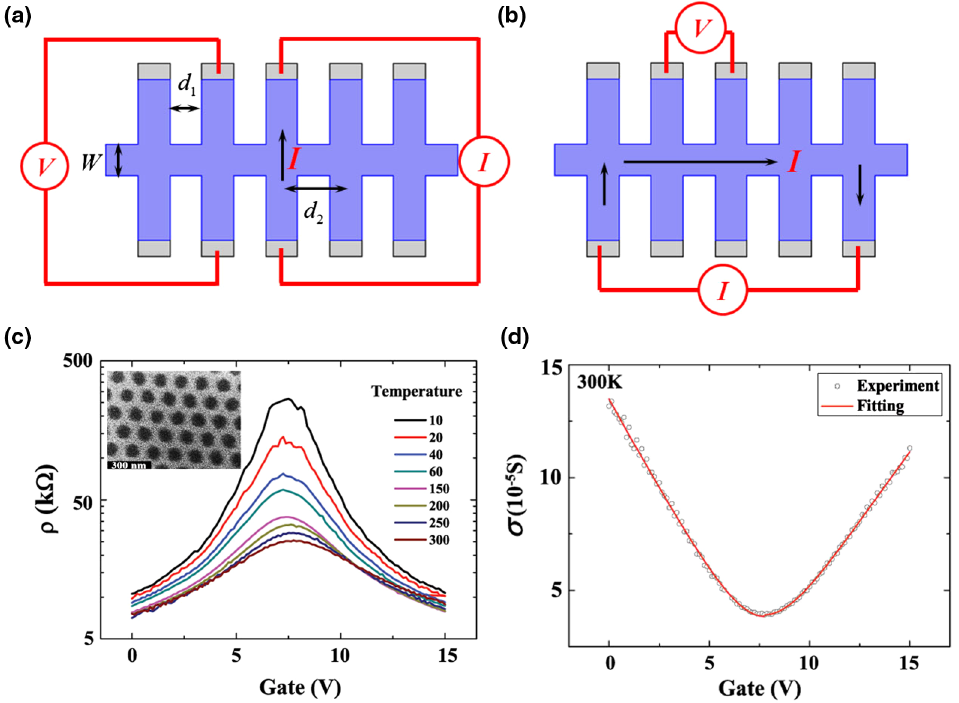
FIG. 7. Measurement setup for (a) nonlocal measurements and (b) local measurements. (c) Antidot graphene resistivity is plotted as a function of gate voltage for various temperatures (from 10 to 300 K). Inset: SEM image for the antidot graphene sample. (d) Room- temperature conductivity as a function of gate voltage is shown to be well fitted by the Boltzmann transport theory, which gives the mobility around 1500 cm 2 = ð Vs Þ and the residue carrier density n 0 ¼ 2 × 10 11 = cm 2